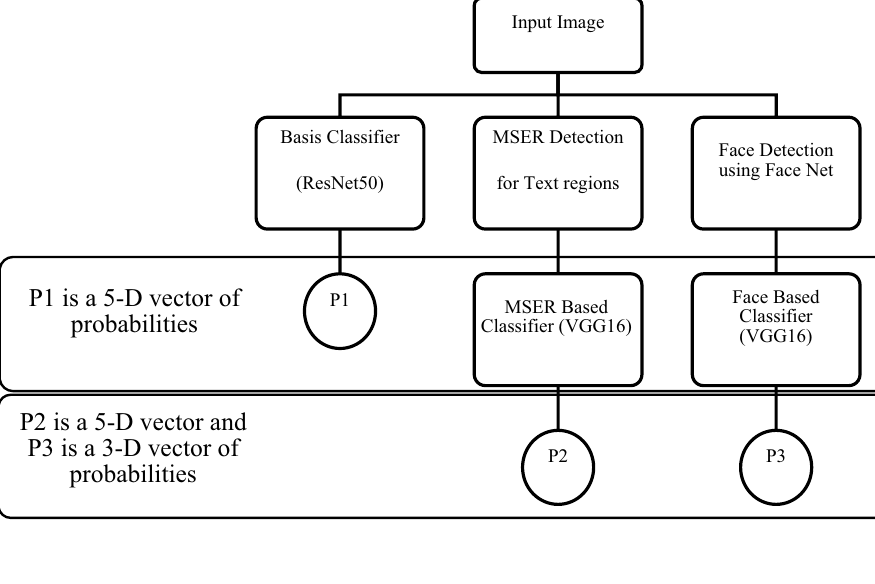
Fig. 2 The framework of our model. (P1 indicates features vectors extracted from the pixel in formation, P2 indicates features extracted from MSER regions and P3 indicates, the features extracted from only Face region